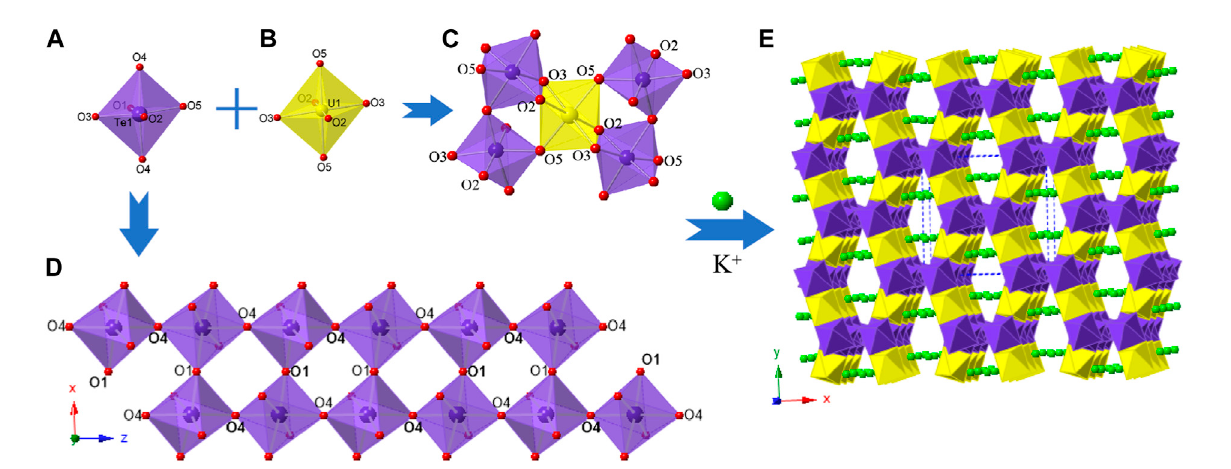
FIGURE 1 K 2 [(UO 2 ) (Te 2 O 7 )]: (A) TeO 6 polyhedron; (B) UO 6 polyhedron, (C) coordination environment for UO 6 ; (D) a Te - O double chain along the c -axis; and (E) view of the 3D structure along the c -axis. K atoms, TeO 6 polyhedra, UO 6 polyhedra, and O atoms are shown in green, purple, yellow and red,